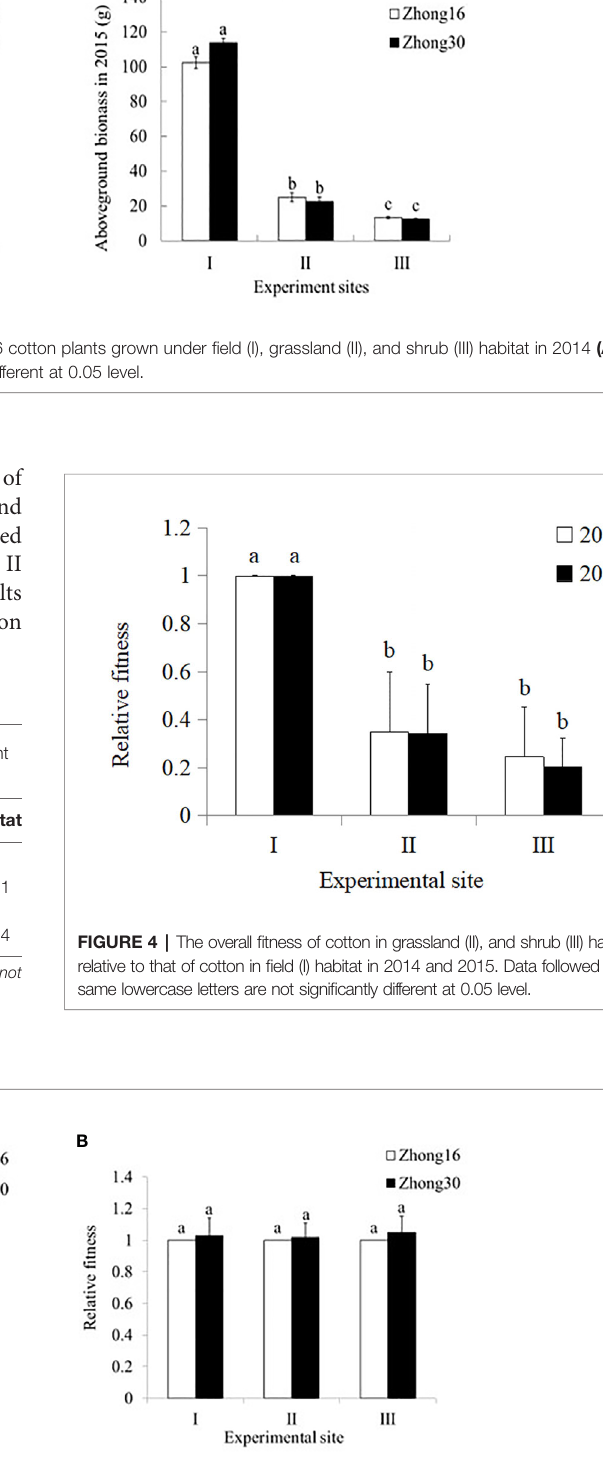
FIGURE 3 | The overall fi tness of transgenic Bt cotton Zhong30 relative to that of non-transgenic cotton Zhong16 grown under fi eld (I), grassland (II), and shrub (III) habitat in 2014 (A) and 2015 (B) . Data followed by the same lowercase letters are not signi fi cantly different at 0.05 level.